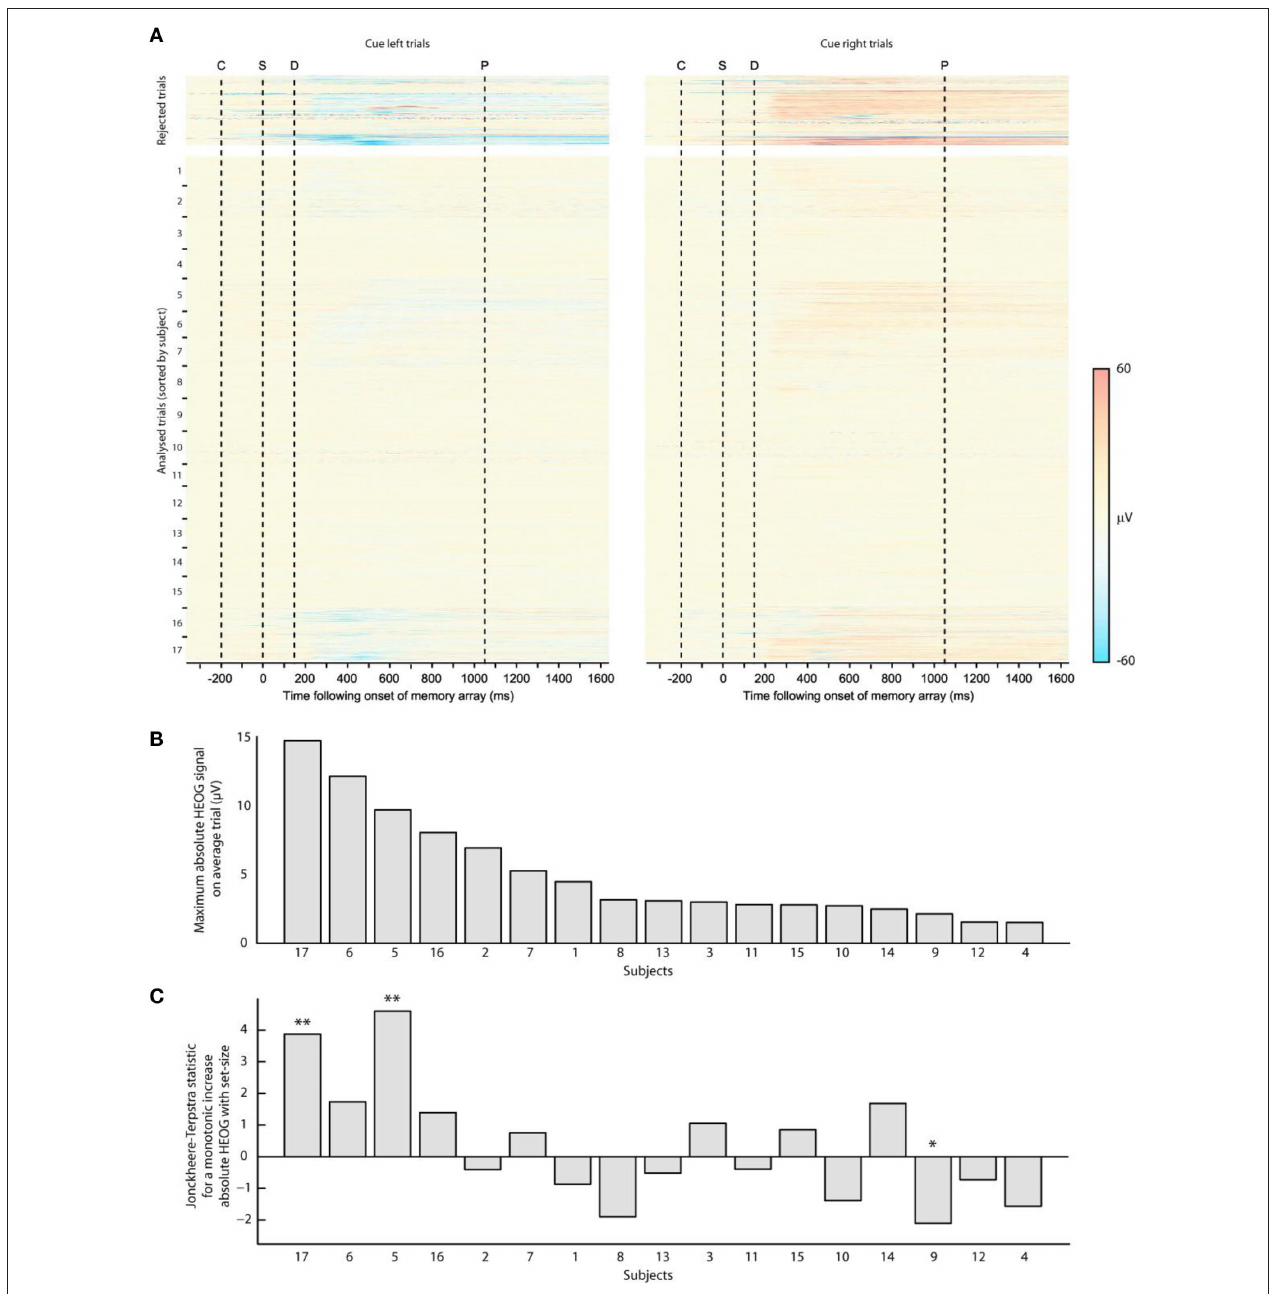
Figure A2 | (A) Horizontal EOG traces from all trials of all subjects, separated into analyzed vs. rejected trials, and trials with leftward vs. rightward cues. The onset of the cue, sample, delay, and earliest possible probe are marked by the dashed lines, labeled C, S, D, and P respectively.